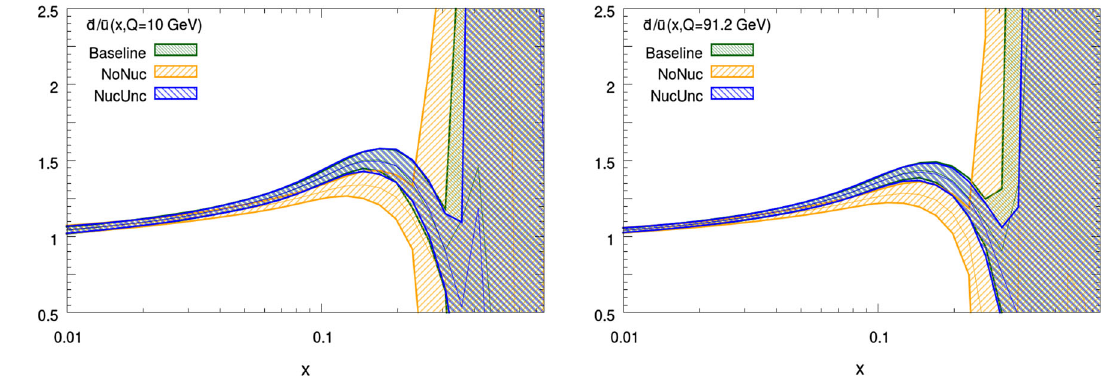
Fig. 13 The ratio ¯ d / ¯ u as a function of x at two representative values of Q for the nuclear data ( Q = 10 GeV) and for the collider data ( Q = 91 . 2